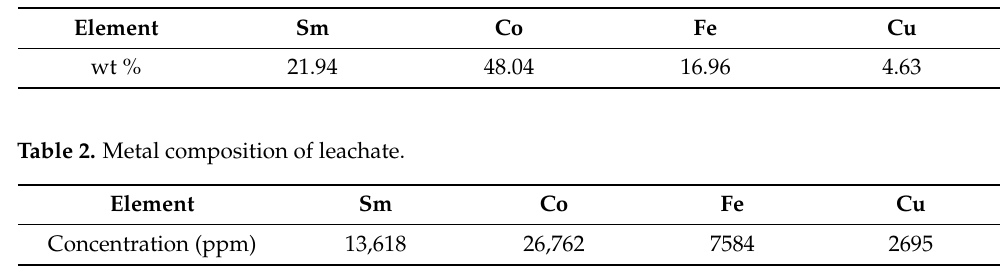
Table 1. Metal content in SmCo5 magnet material.